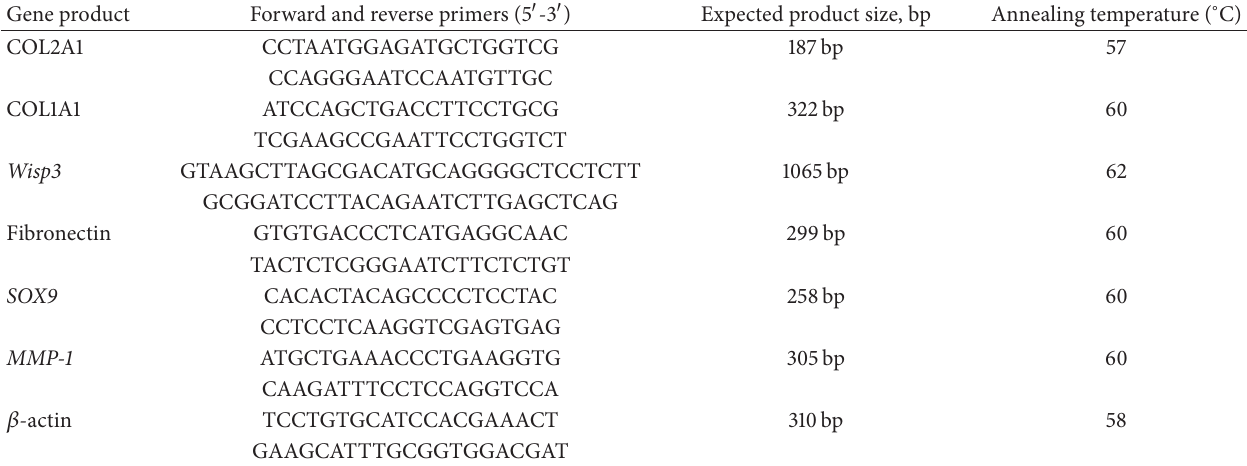
Table 1: Primer pairs and experimental